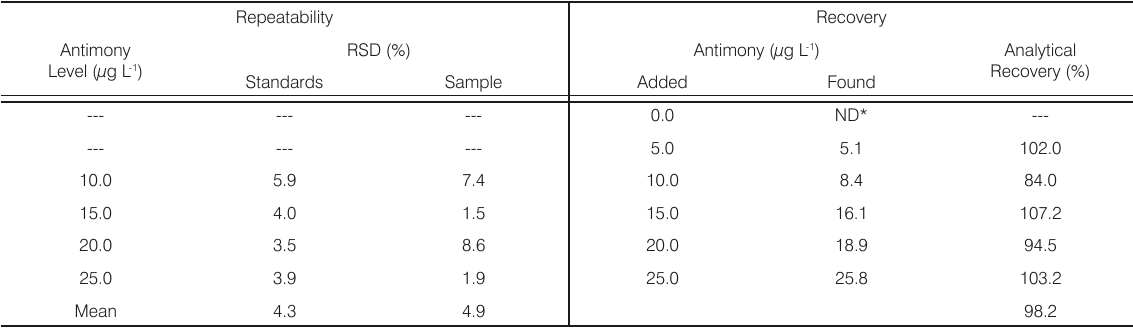
Table 3. Results of the studies on the repeatability (expressed as % RSD of the measurements) and on the analytical recovery within the linear range of concentrations, for standards and for a spiked tap water